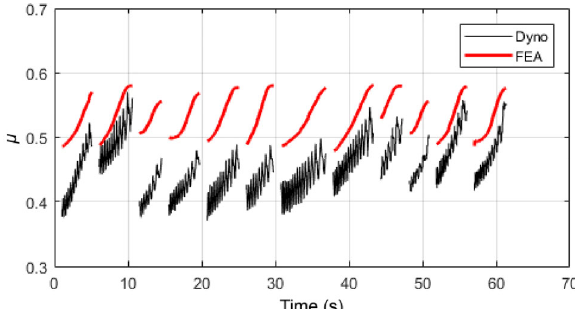
Fig. 9 COF time history during the selected braking. Experimental COF in black, FEA COF in red.